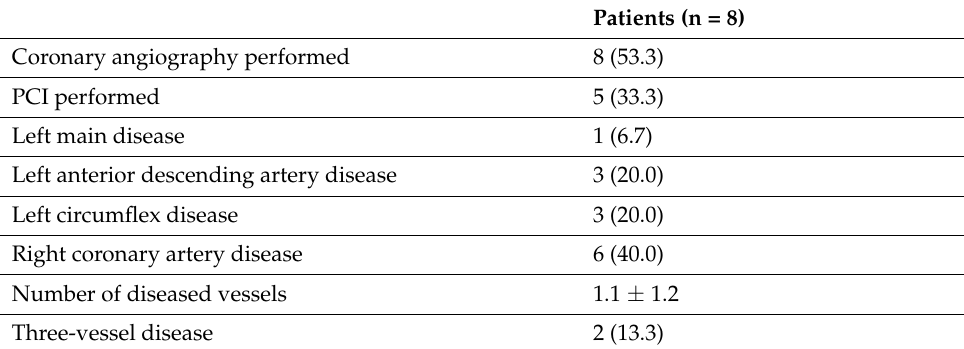
Table 3. Angiographic and procedural